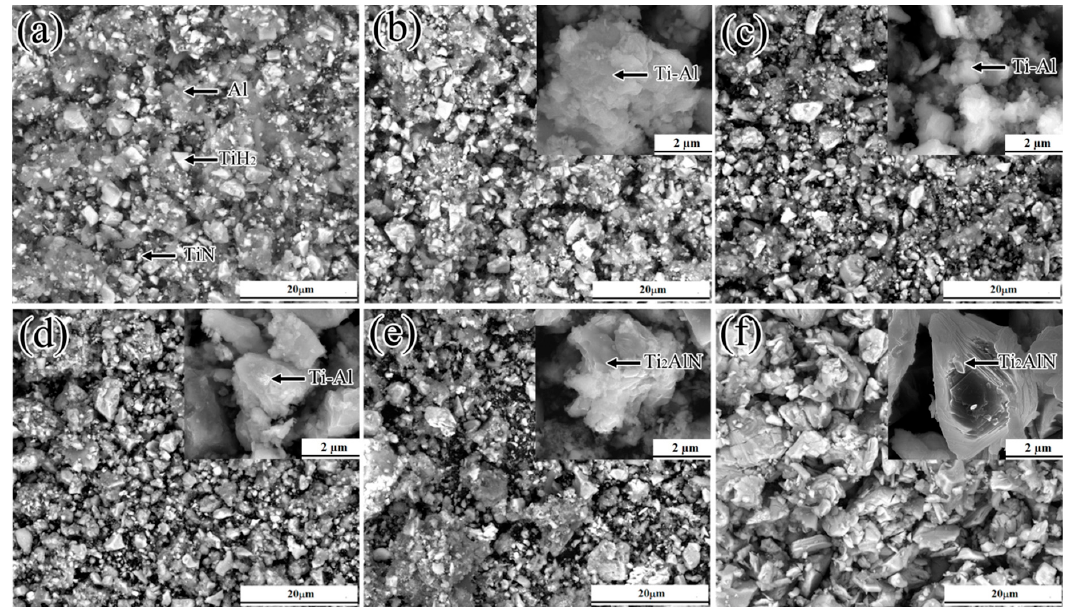
Figure 8. SEM images of the samples prepared at different sintering temperatures: ( a ) un-sintered 1TiH 2 /1.15Al/1TiN powder mixture; ( b – e ) after 1 min of sintering at 620, 720, 820, and 920 °C, respectively; and ( f ) after 30 min of sintering at 1250 °C.